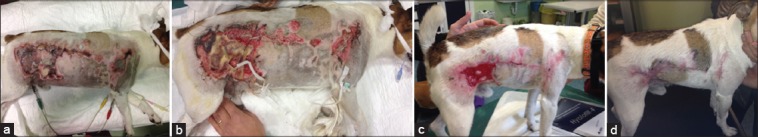
Wound healing evolution for Wound 6 and 7, (a) Wound status at admission: Two areas of discolored tissue were present on the right lateral side of the trunk (wound 6 on the flank and wound 7 on the scapular region). The two wounds were filled by a dry black and yellow eschar. Both wounds were treated with medical debridement. For wound 6 a tie-over bandages was applied, (b) wound status after 4 days: The eschars became an easy to remove yellow non-fixed mushy necrotic tissue. An initial pink granulation tissue was present under the necrotic tissue. Multiple, loose, simple interrupted, monofilament, non-absorbable suture were used to secure in place the medication and the bandages for the wound on the flank (tie-over bandage), (c) wound status after 15 days: A decrease of wound dimension was easily appreciated. Wound 7 was almost complete epithelialized. The bottom of the wound 6 was filled by a healthy red granulation tissue, (d) wound status at 54 days: A complete epithelialization of the wound 6 was achieved.